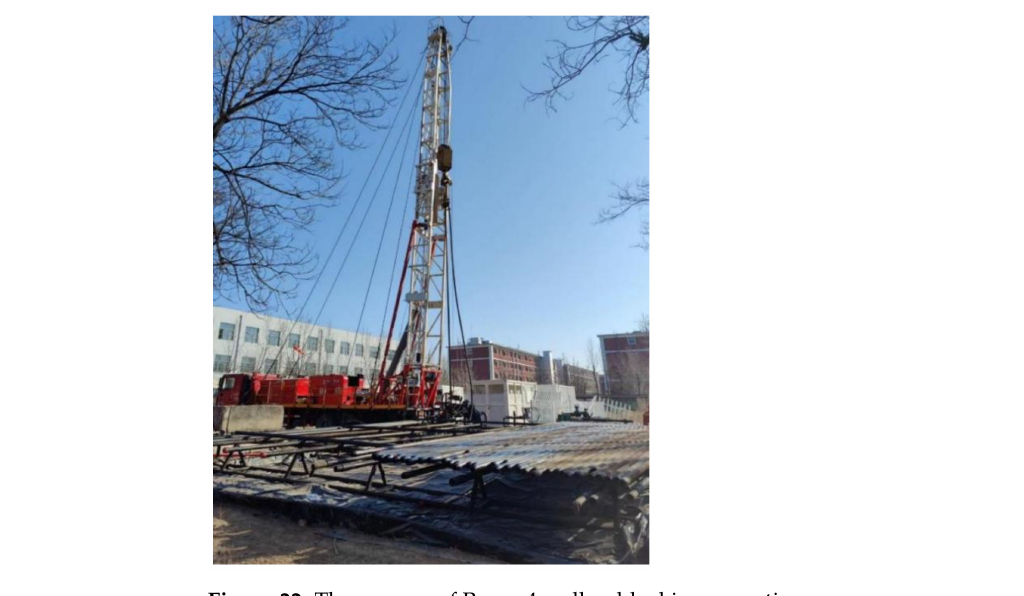
Figure 22. The process of Renre 4 well unblocking operation. Table 2. Unblocking operation parameters of Renre 4 well.